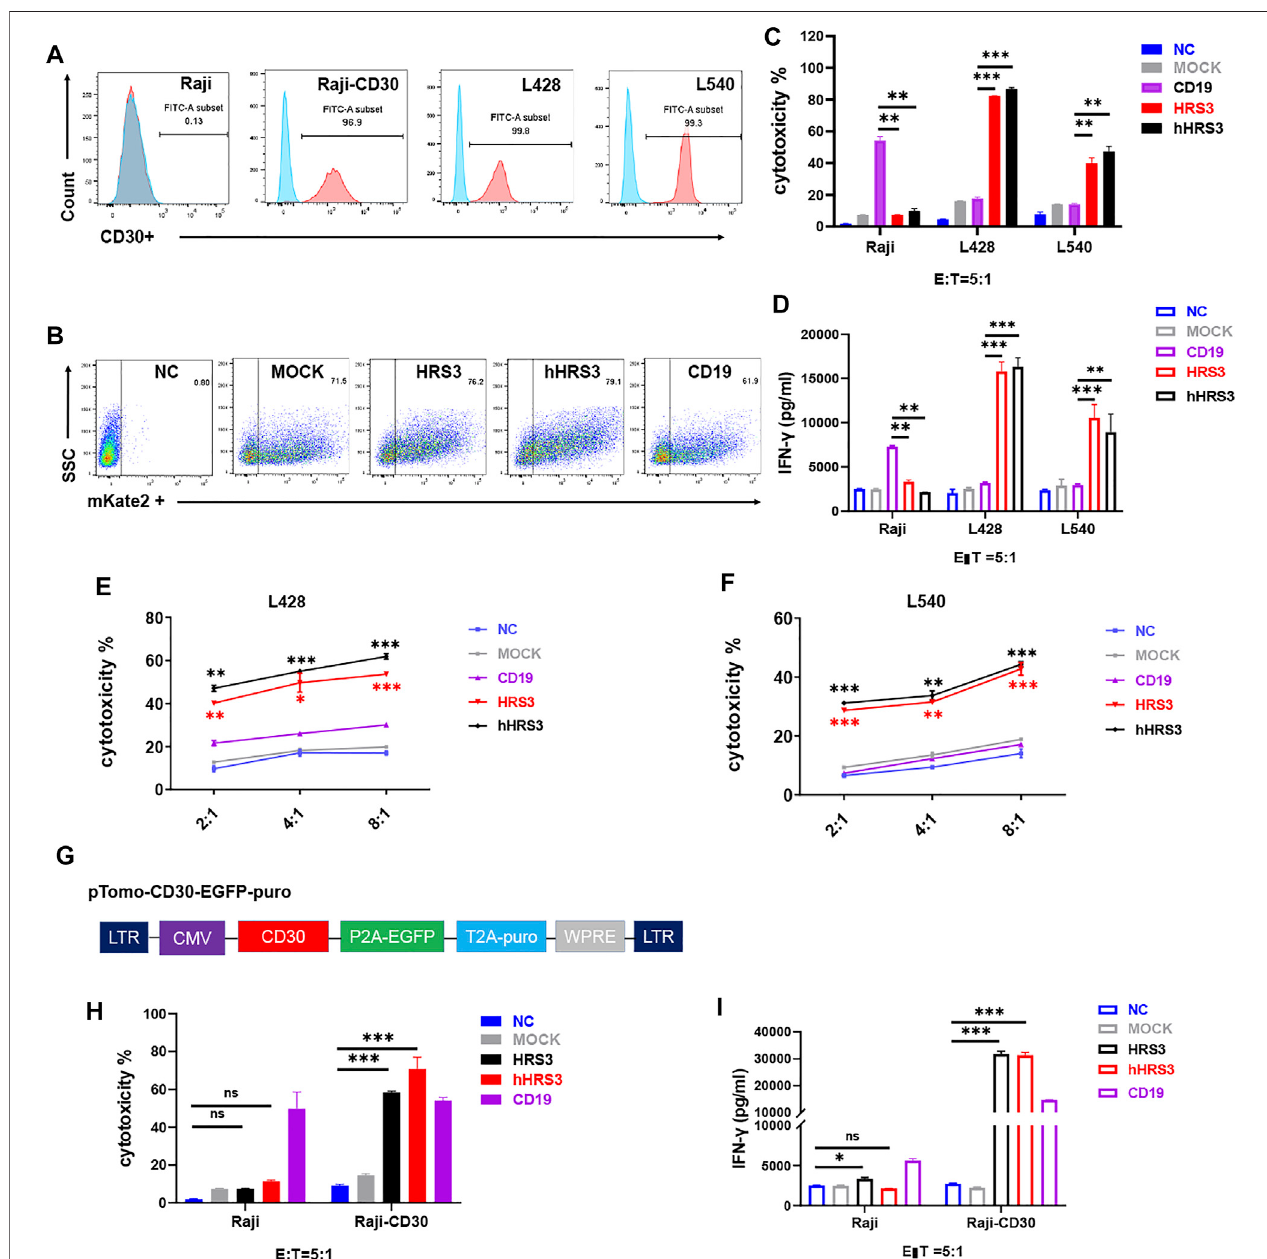
FIGURE 2 | CARs with humanized HRS3-speci fi c scFv recognize CD30 + tumor cells. (A) B cell lymphoma and Hodgkin ’ s lymphoma (HL) cell lines were stained withamonoclonalantibodyspeci fi cfortheCD30antigenandanalyzedusing fl owcytometry.CD30expressionwasevidentinamajorityofthecelllinesafterstainingwith an anti-CD30 monoclonal antibody (Pink) when compared to staining with control antibody (Blue). Raji was used as negative control. (B) Flow-cytometry analyses in a representative donorshowing CARexpression. (C) Tcells expressing hHRS3-CAR and HRS3-CAR exhibited cytotoxicityagainst thenon-HL and HL cell lines in a 24-h assay. Graphs show mean ± SEM of duplicate wells. One of two representative experiments with different donor cells and similar results is shown. (D) IFN- γ concentrations in the supernatants of CD30-CAR-T-cells after stimulation with Raji, L428, and L540 cells for 24 h, analyzed by ELISA. (E,F) In vitro cytotoxic assay to evaluatecytolyticactivityofNCTcells(Blue line),CD19-CAR-Tcells(Purpleline),HRS3-CAR-T cells(Redline)and hHRS3-CAR-T cells(Blackline)onCD30 + lymphoma cell lines, namely L428 and L540 cells. The results are presented as the mean volume ± SD, * p-value < 0.05, ** p-value < 0.01, *** p-value < 0.001 vs CD19 (CD19 as negative control). (G) Diagram of the full-length overexpressing human CD30 vector. (H,I) Detection of Raji and Raji-CD30 cell killing and cytokines (CD19 as positive control). “ NC ” representsuninfectedTcells(negativecontrol). “ MOCK ” indicatesthetransgenicplantthatcontainedonlythevectorconstruct(negativecontrol).Thedata werederivedfromdifferentdonorcellsandthe invitro experimentswererepeatedindependentlyatleastthreetimes.Theresultsarepresentedasthemeanvolume ± SD, * p-value < 0.05, ** p-value < 0.01, *** p-value < 0.001 vs NC.